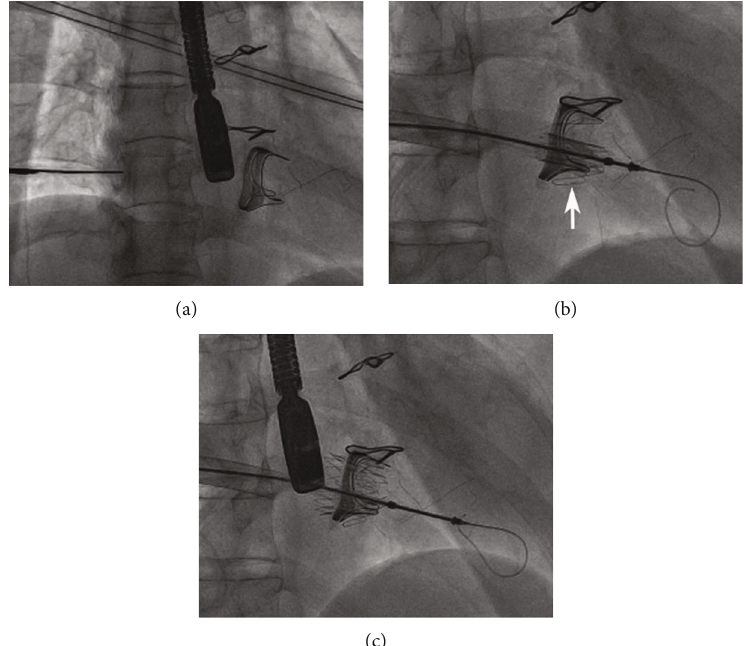
Figure 3: Step-by-step transatrial TVIV implantation of the J-valve. The right atrium puncture according to the coaxial position of the tricuspid annulus (a). The three “ U-shape graspers ” were released and embraced the prior bioprosthetic struts (white arrow) (b). Full deployment of the J-valve (c).